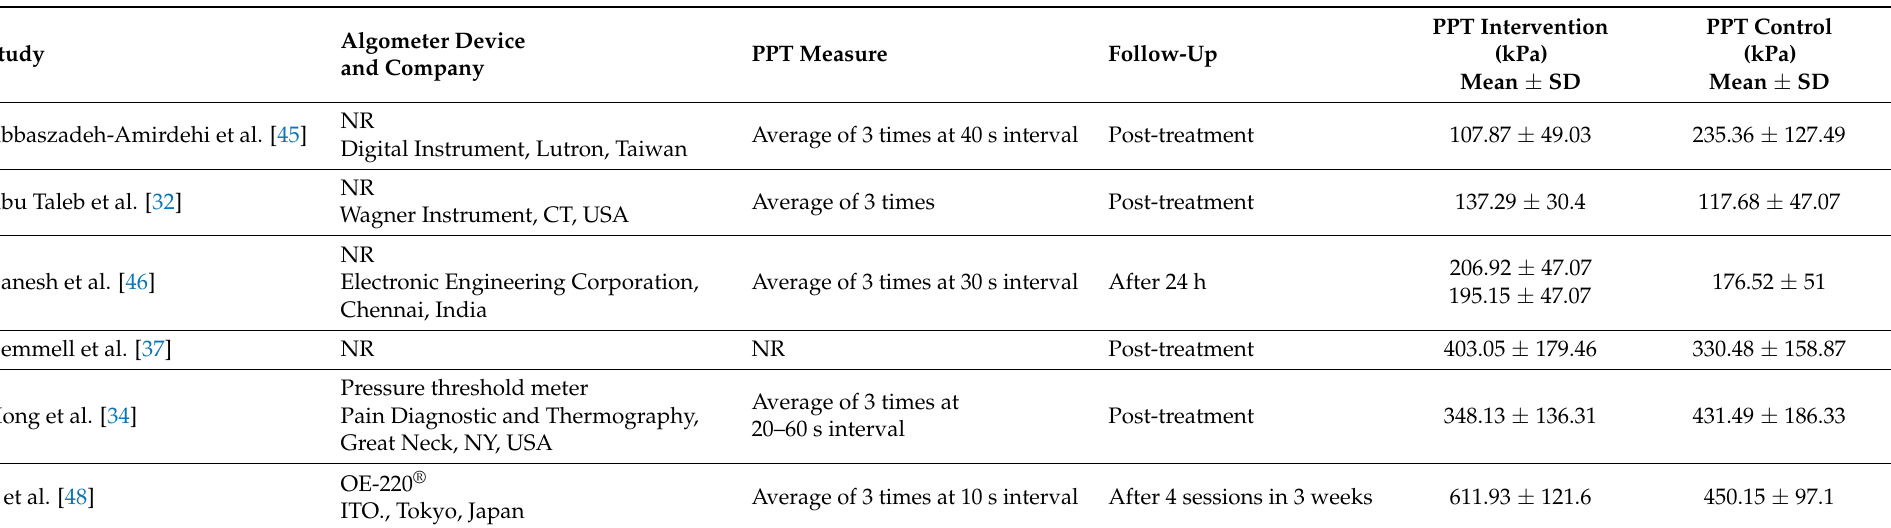
Table 2. Characteristics of algometry and PPT values among